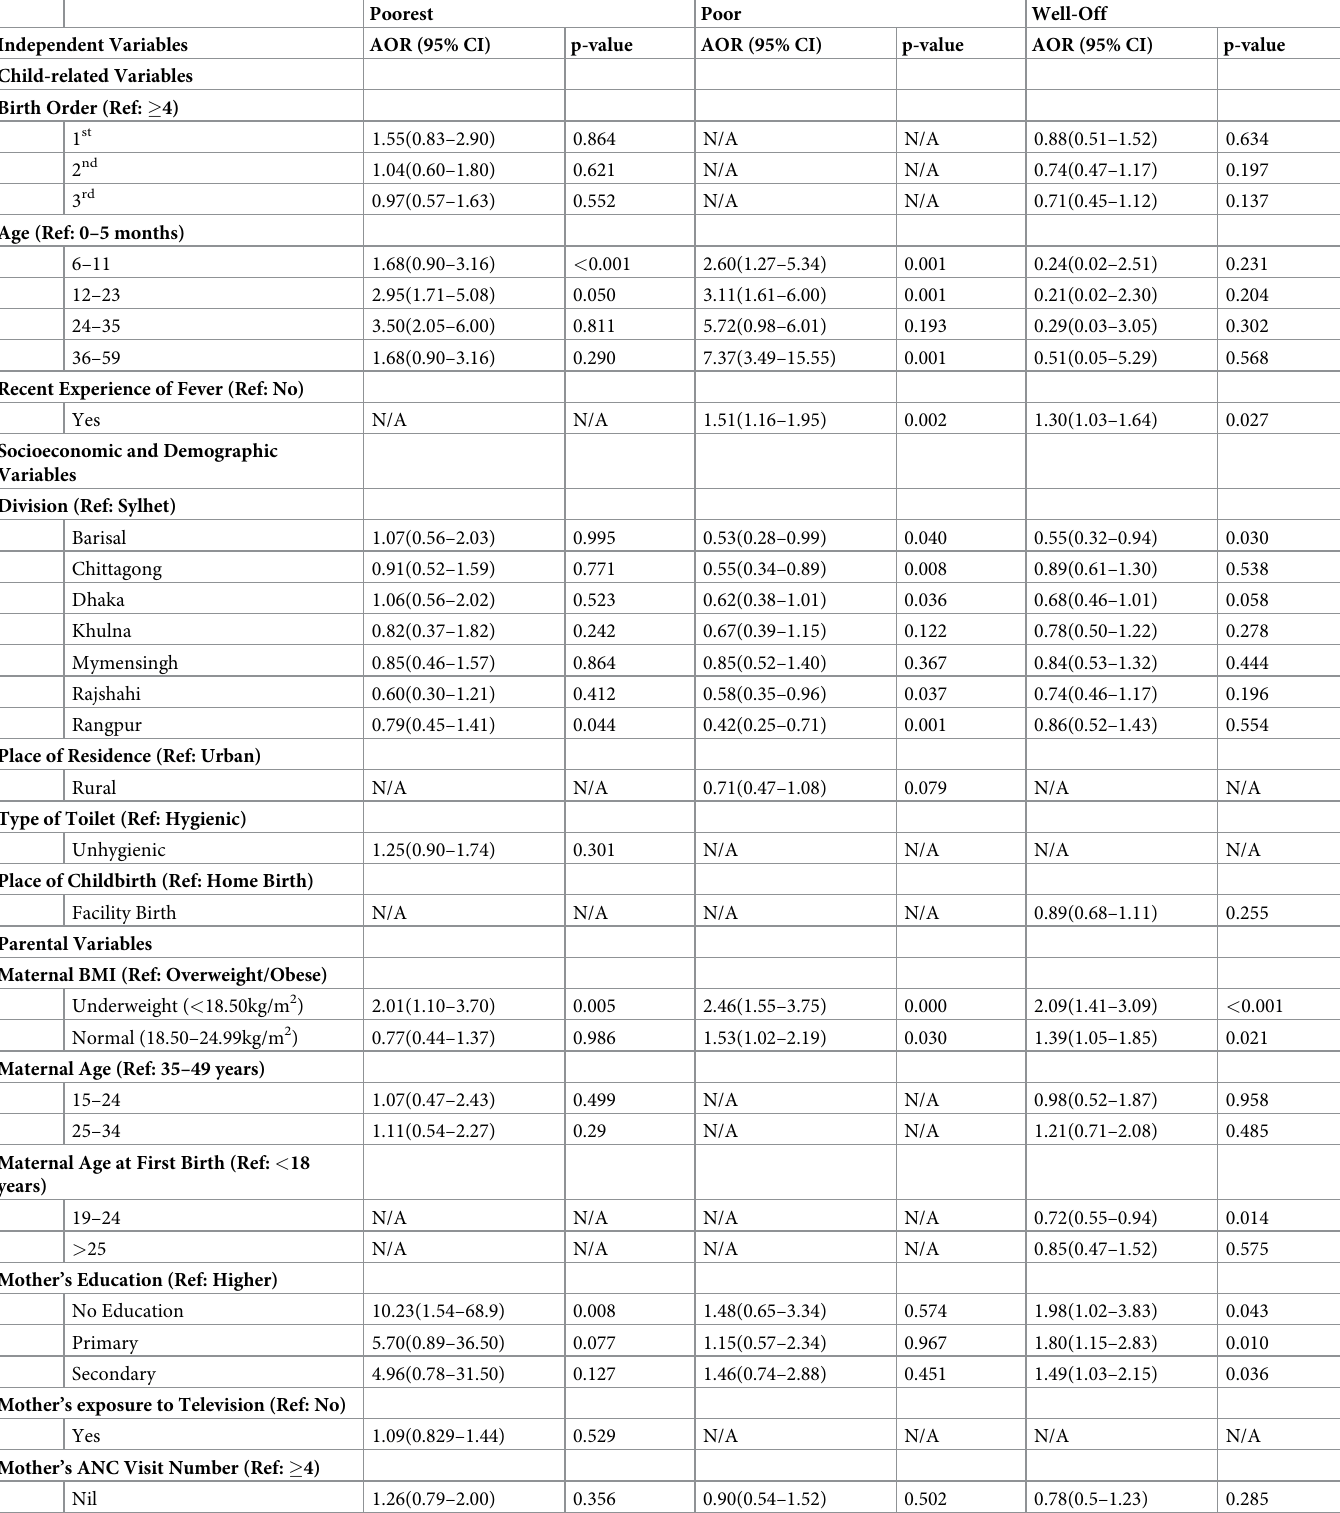
Table 4. Factors associated with underweight within different categories of wealth